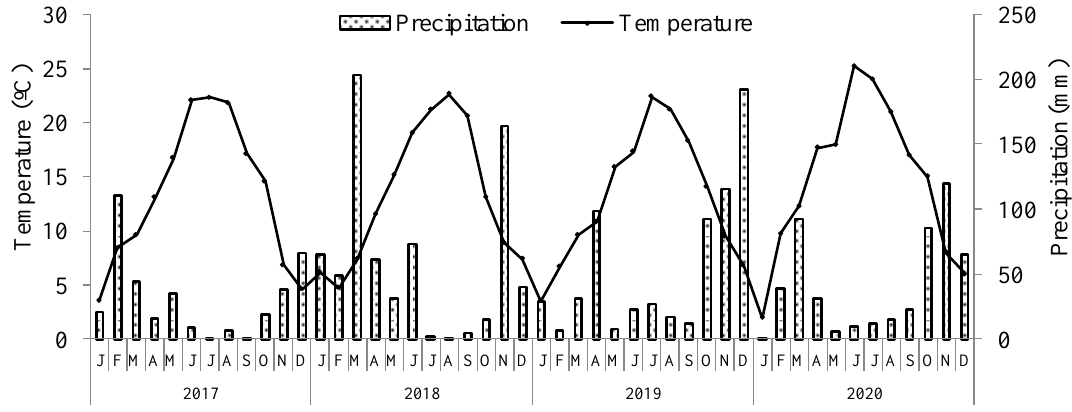
Figure 1. Average monthly temperature and precipitation during the experimental period. Table 1. Selected Soil (0–20 cm) Properties (average ± standard deviation) Before the Trial Started. Soil Properties